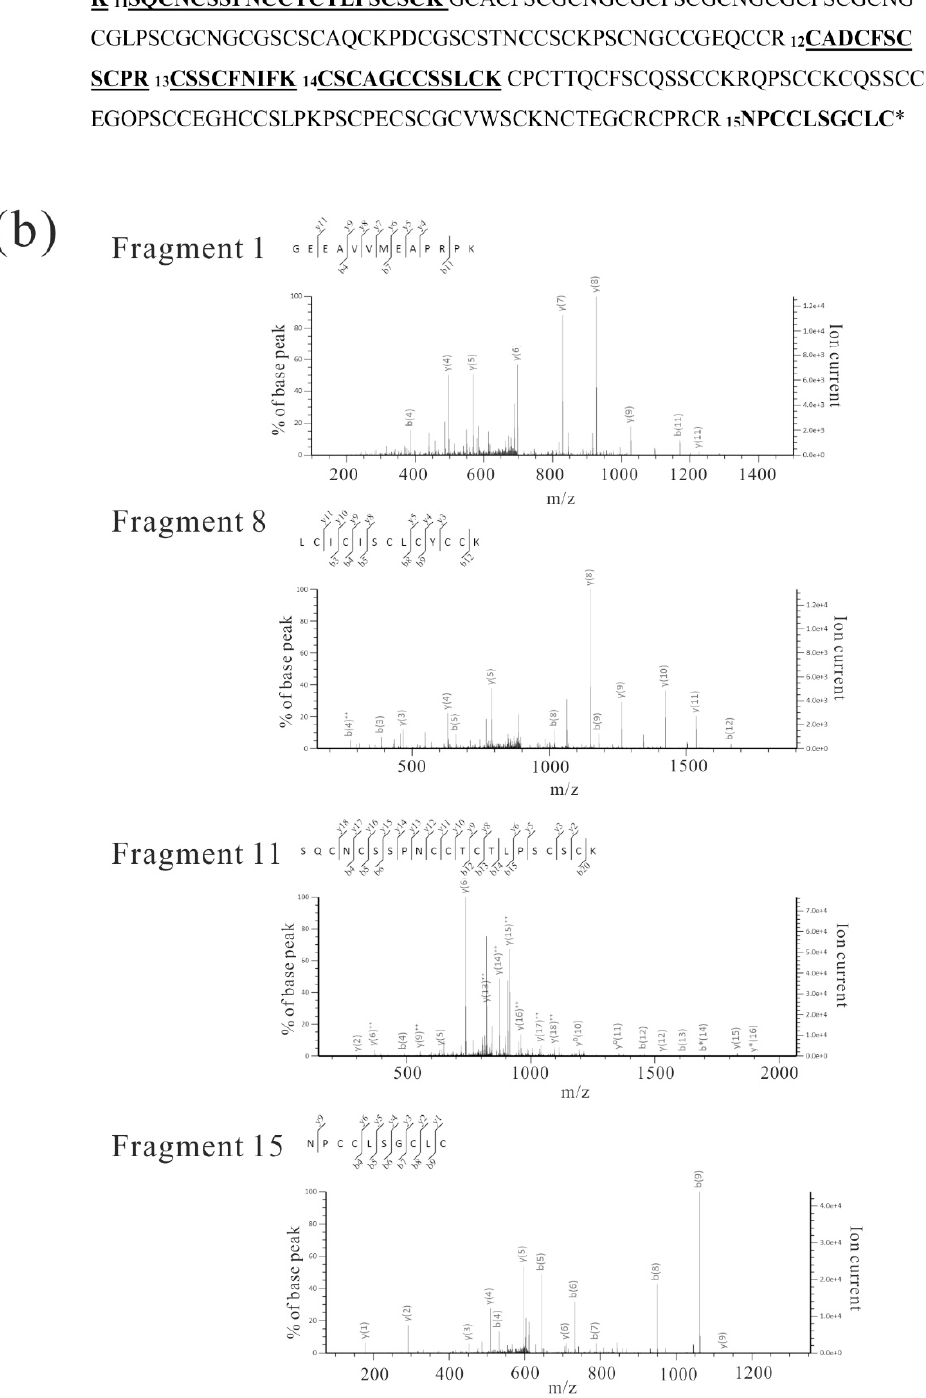
Figure 4. LC-MS/MS analysis of G γ 4 candidates from WT leaf sheath. ( a ) Fifteen peptides ( p < 0.05) produced by trypsin-digested G γ 4 candidates in wild type (WT) and Dn1-1 are numbered and underlined in the full-length G γ 4 amino acid sequence. These peptides are listed in Table 1 (A and B). ( b ) MS/MS spectra of four fragments, which were obtained as immunoprecipitation product of G γ 4 in WT (Figure 3a, lane 3). Fragment numbers correspond to Table 1 (A and B).